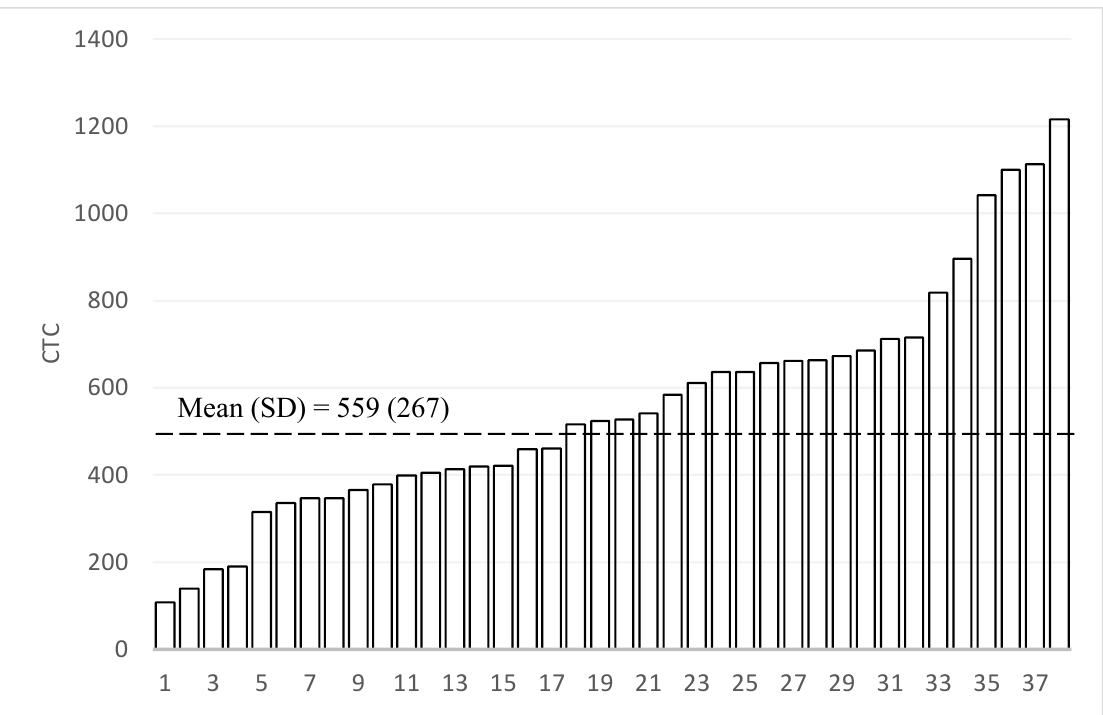
Figure 2. Distribution of Adult Word Count (AWC, N = 38). “SD” is defined as standard deviation.